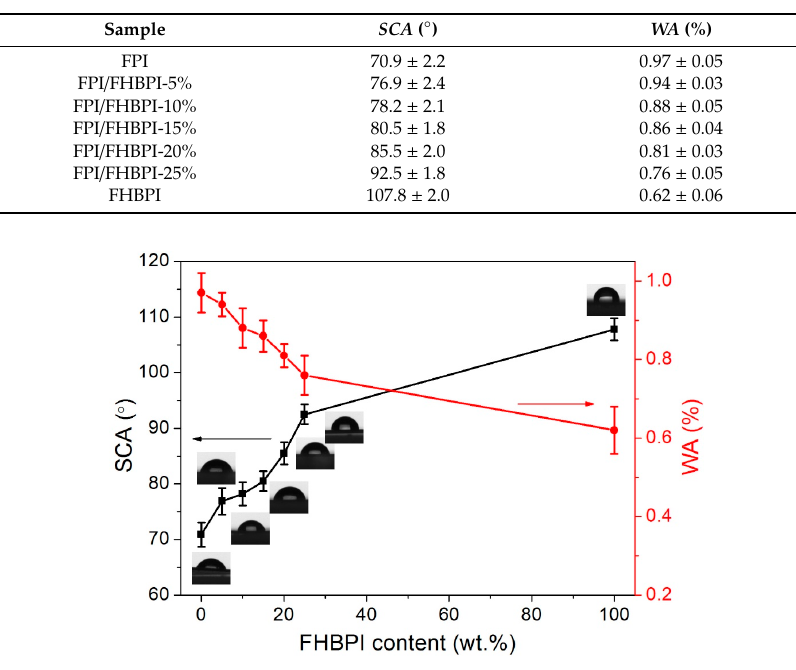
Table 3. Surface contact angle ( SCA ) and WA of FPI, FPI / FHBPI composites and FHBPI.